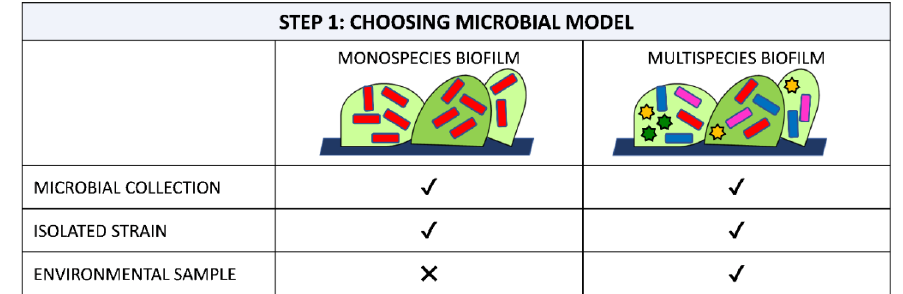
Figure 1. Scheme representing the first step in the experimental procedure for testing new anti-biofilm materials. The choice of the relevant model microorganisms includes the use of strains from microbial collections, strains isolated from the environment or complex environmental community samples used without any cultivation steps, in both mono- and multi-species biofilm models.